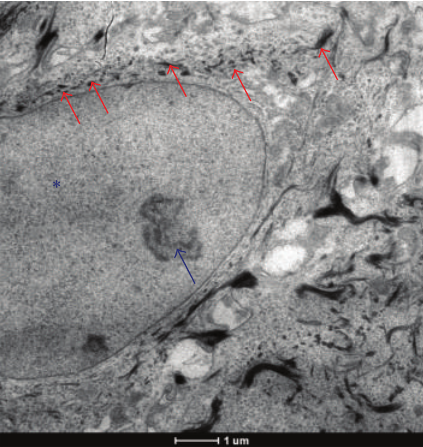
Figure 1: TEM images of a fibroblast present in a healed skin sample treatedwithAgNPbasedmedicaldevices.Thecellsarehealthyasthe right morphological features show: integrity of plasma membrane, nuclear integrity (blue ∗ ), and active nucleolus (blue